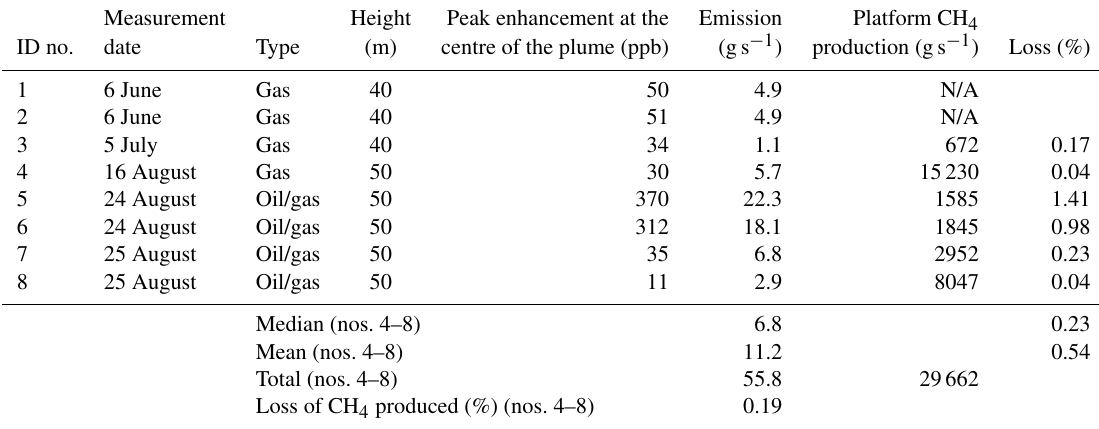
Table 1. Meteorological, position and mole fraction data taken during the boat-based measurement campaign around oil and gas production platforms in the North Sea between 6 June and 25 August 2017. Emissions were calculated assuming the source of the emissions was at the working deck level. The calculations of the median, mean and total only use data from platforms nos. 4–8. Platforms nos. 1–2 did not have production data available for the time of measurement. During the measurement of platform no. 3 the height of the PBL was calculated as zero (GFS, 2019), making the Gaussian plume modelled emission estimate